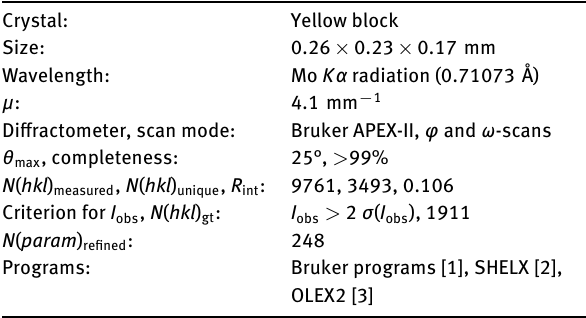
Table 2: Fractional atomic coordinates and isotropic or equivalent isotropic displacement parameters (Å 2